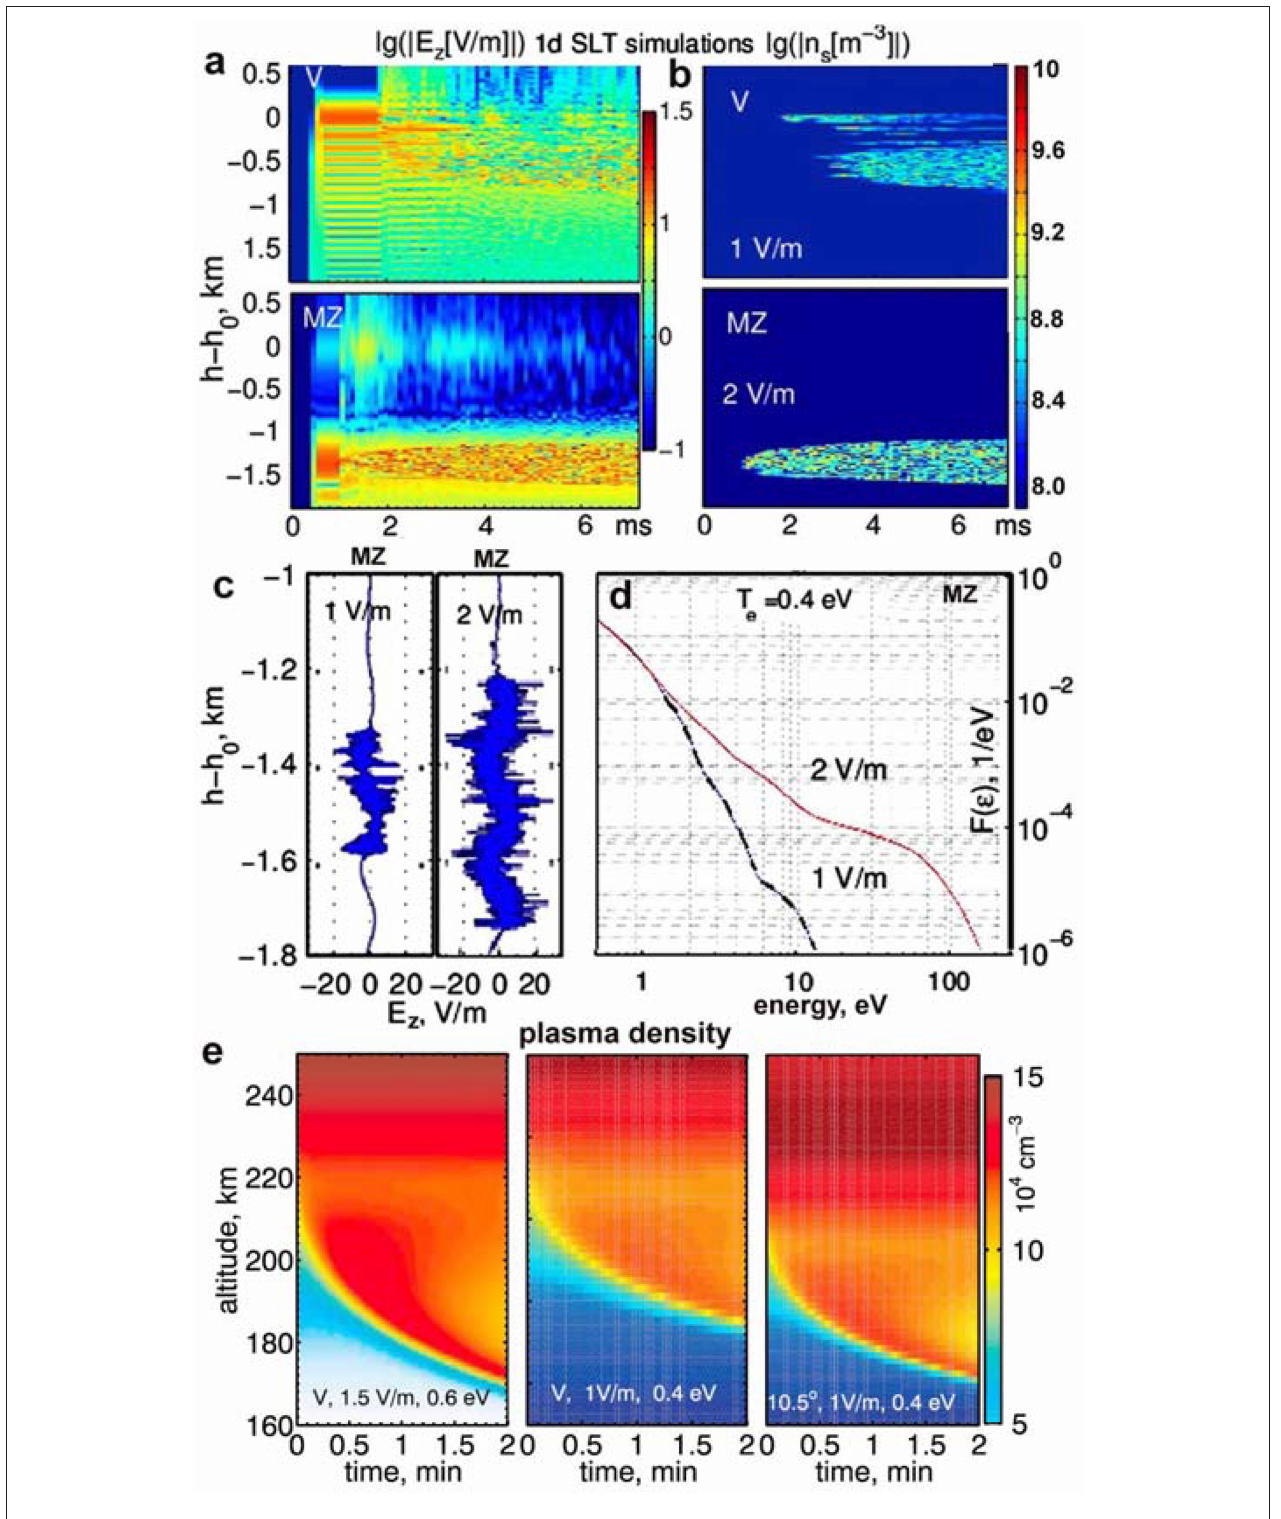
E z [V/m] δ n s [m − 3 ] ) and (b) log 10 ( ) for E in = 1 and 2 V/m at V and MZ, as indicated in plots; (c) | | | | F t ( u ) du / d ε ; and (e) time-vs.-altitude plots of the plasma density at V and 10.5 ◦ S calculated for various =